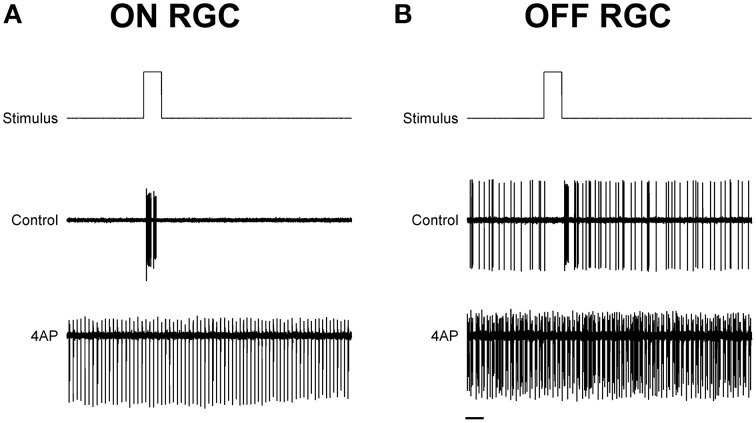
Exemplar light induced ON and OFF responses in rat RGCs. (A,B) Spike recordings and the effect of light pulses (1 s) in two exemplar ON (A) and OFF (B) RGCs. Top lines are the schematic representation of the light stimulus. The middle and bottom traces are representative spike recording traces before (Middle) and during (bottom) the application of 4-AP (0.02 mM). Notice how the application of 4-AP increases spontaneous activity and reduces the stimulus dependent variation in the cell activity. Black scale bar is equal to 1 s.